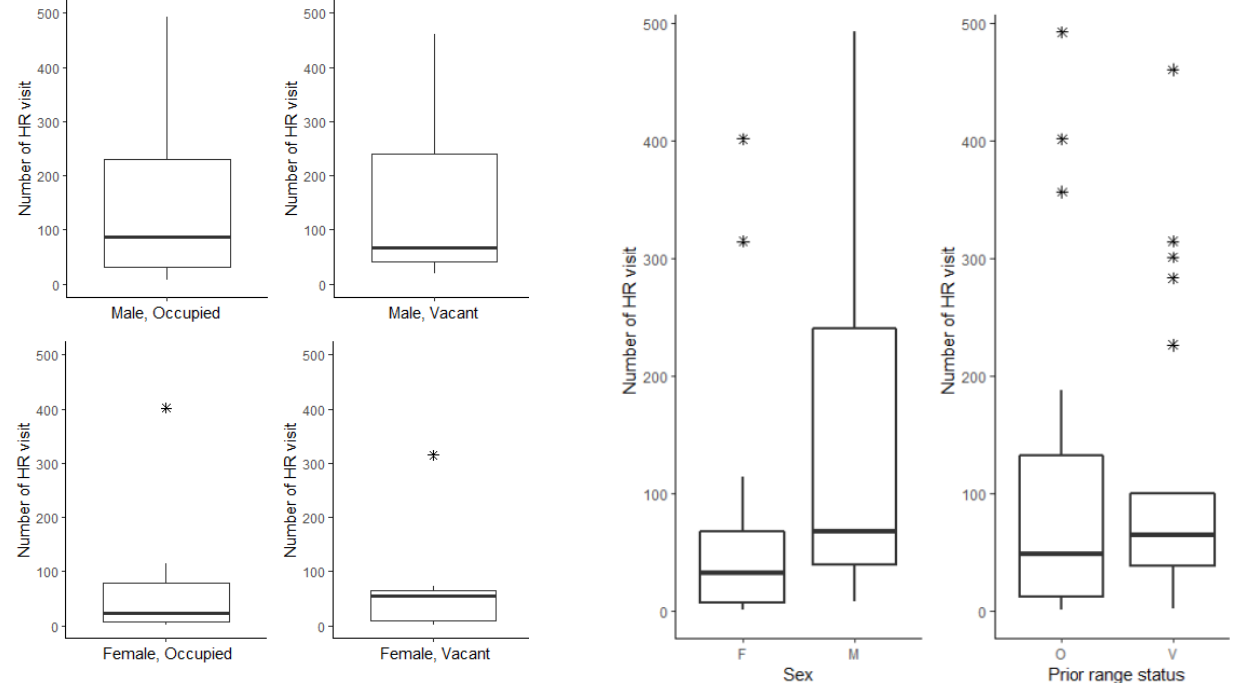
Figure 1. Illustrations of some results from analyses, with number of daily prior visits to the home range as the dependent variable ( y axes). Presentations are box and whisker plots according to selected independent predictor variables ( x axes). Solid black horizontal lines show medians, and box limits correspond to the first and third quartiles (25 and 75 percentiles). Whiskers (vertical lines) show values extending 1.5 times away from this inter-quartile range, and asterisks show values which were greater. The upper panels show results for sex and prior range status. With the suggestion of some influence of sex (upper left graphic), the middle panels show results for males according to prior range status (vacant or occupied), with corresponding results for females in the bottom panels.